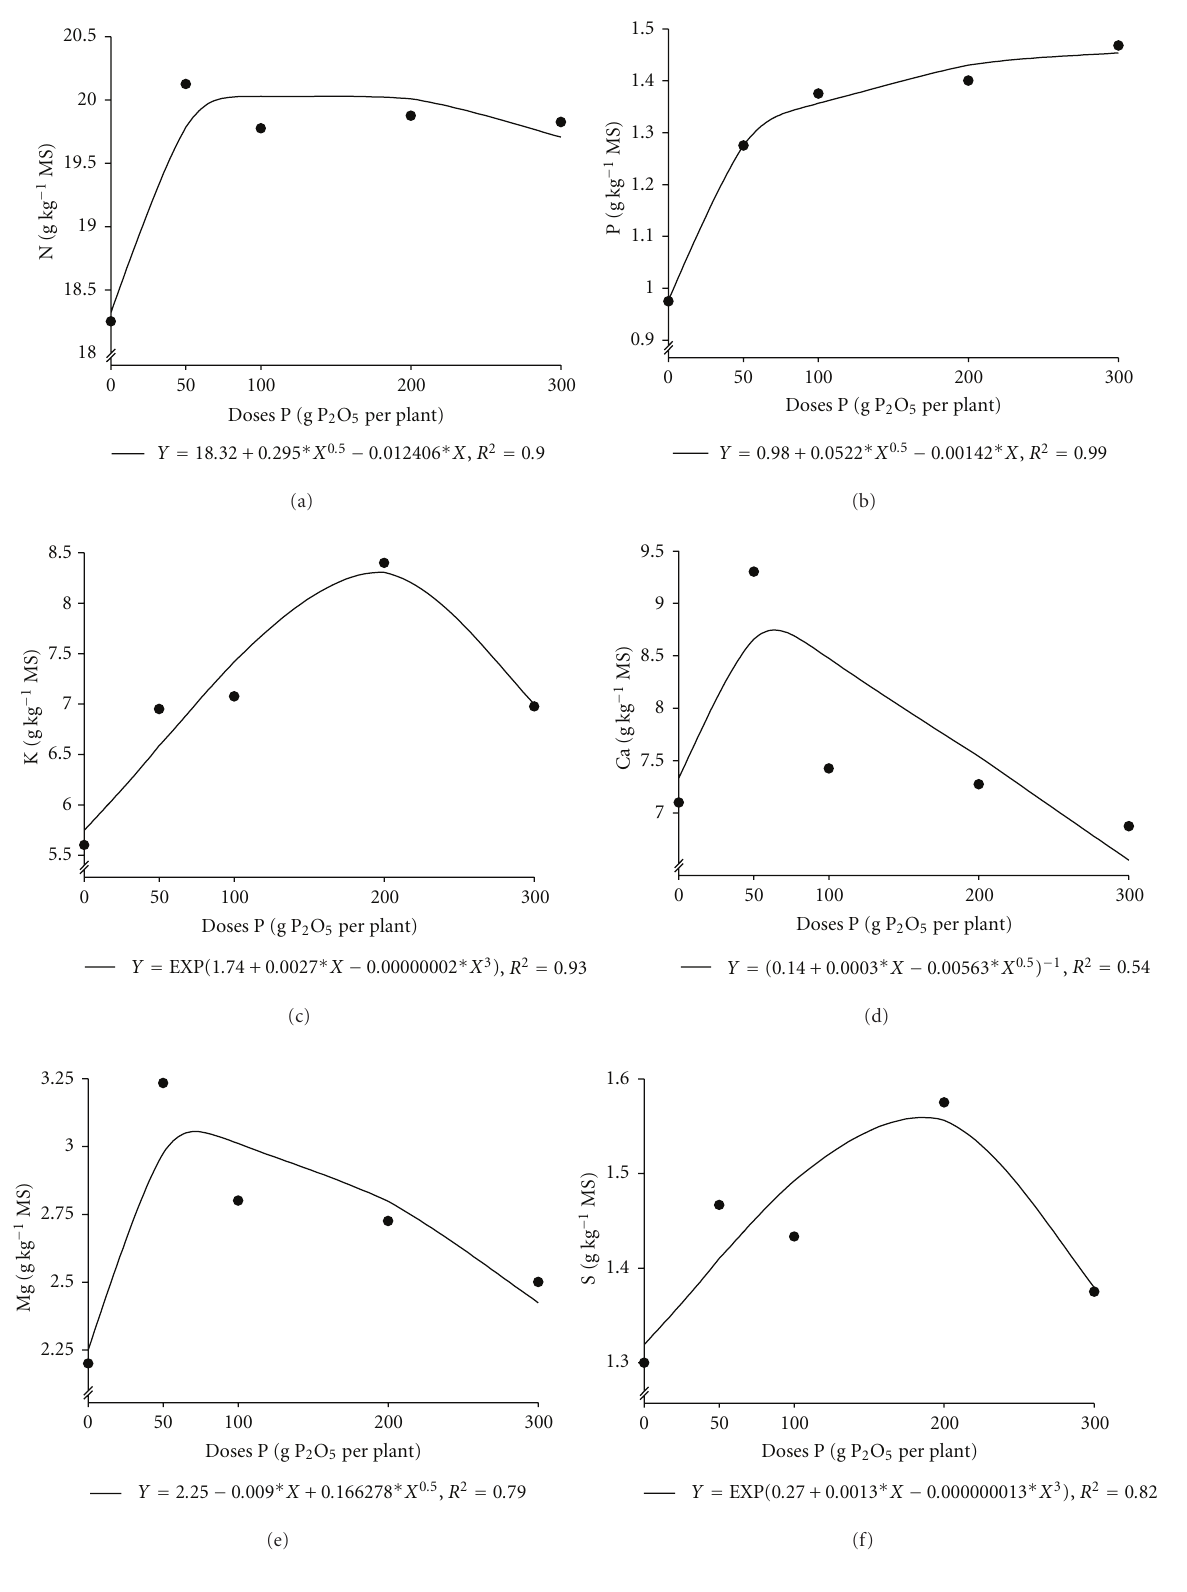
Figure 2: E ff ect of phosphorus applied at planting on lychee plants foliar levels of N (a), P (b), K (c), Ca (d), Mg (e), and S (f). ∗ Significant P < 0 .